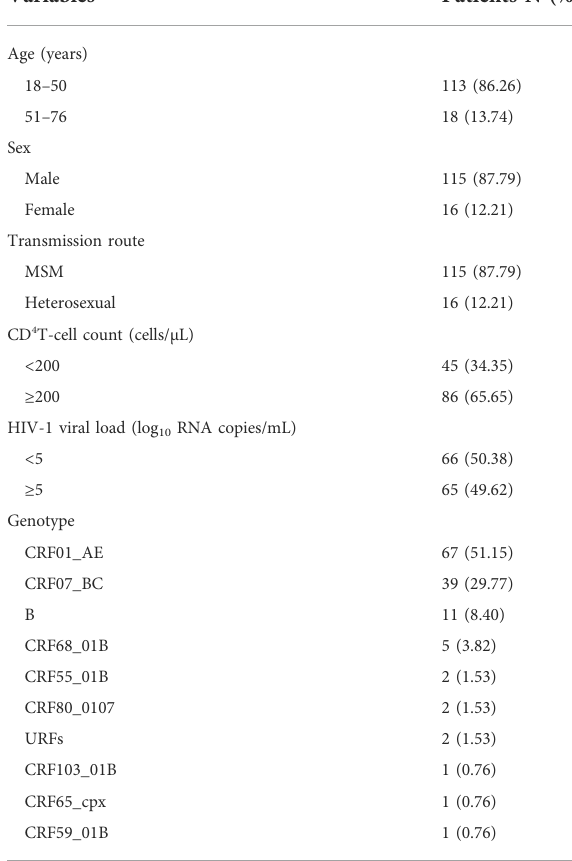
TABLE 1 Clinical characteristics of patients at